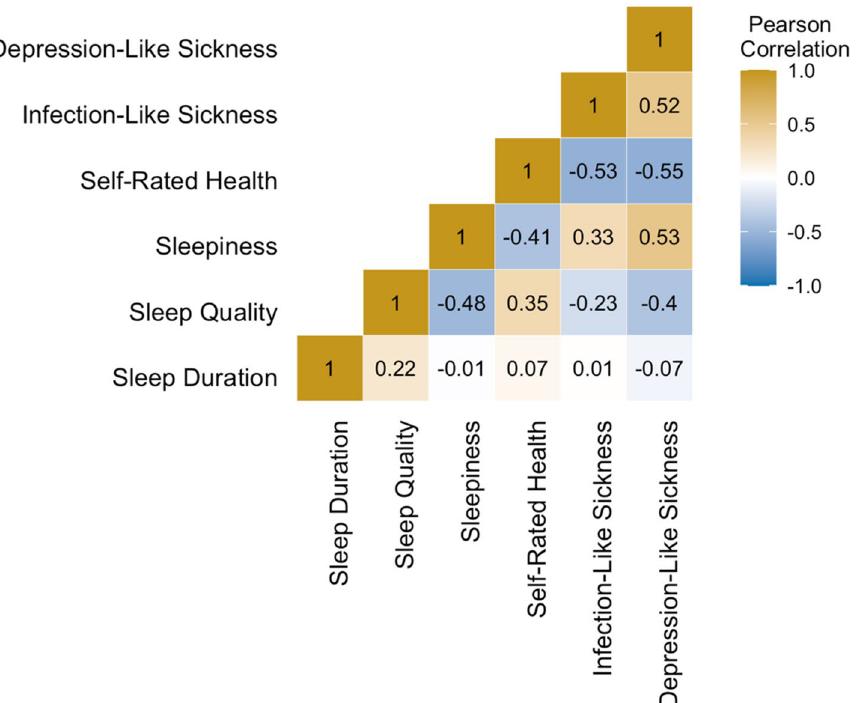
Figure 1. Heatmap showing Pearson correlation coefficients between all sickness variables (depression-like sickness, infection-like sickness, self-rated health) and sleep health variables (sleepiness, sleep quality, sleep